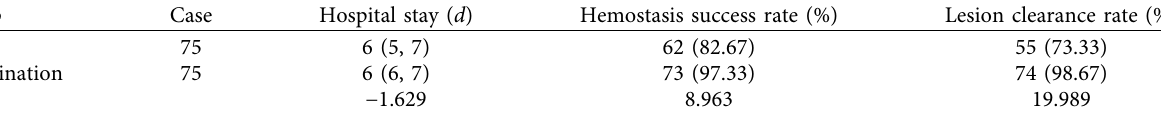
Table 1: Comparison of surgery-related indicators between the two groups ( x ± s , n (%)).